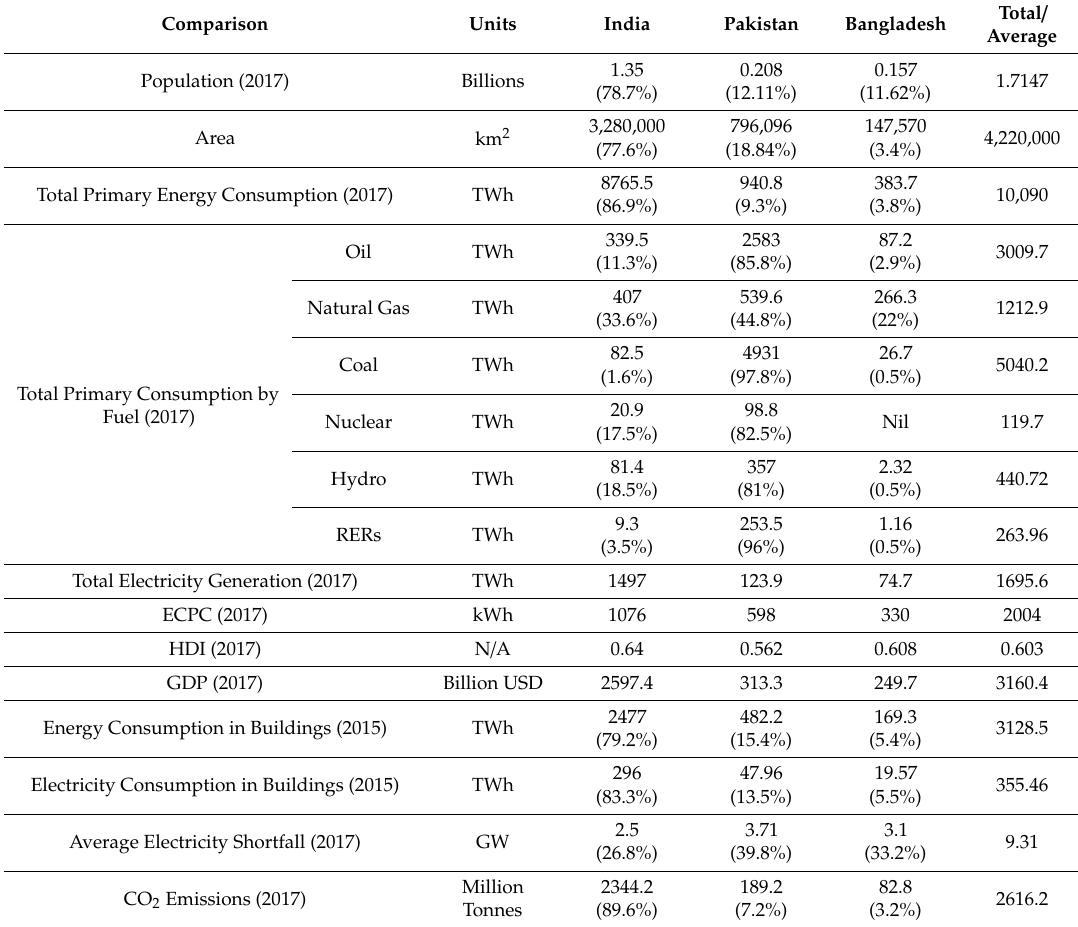
Table 1. Comparison of Energy Overview of